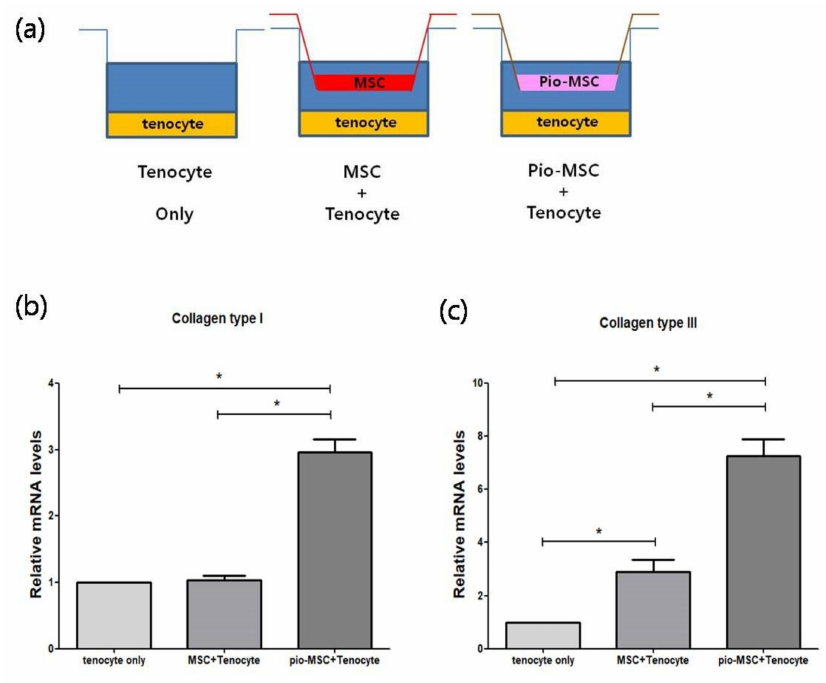
Figure 5. Comparison of relative soluble collagen secretion following co-culture with tenocytes, MSCs, and Pio-MSCs using an indirect transwell system. ( a ) Schematic model of the co-culture system used. ( b ) Tenocytes, MSCs, and Pio-MSCs were each co-cultured with tenocytes for 48 h. The concentration of collagen was then measured using a SirCol assay. The data are expressed as a mean ± standard error (SE) from three replicates. * p <